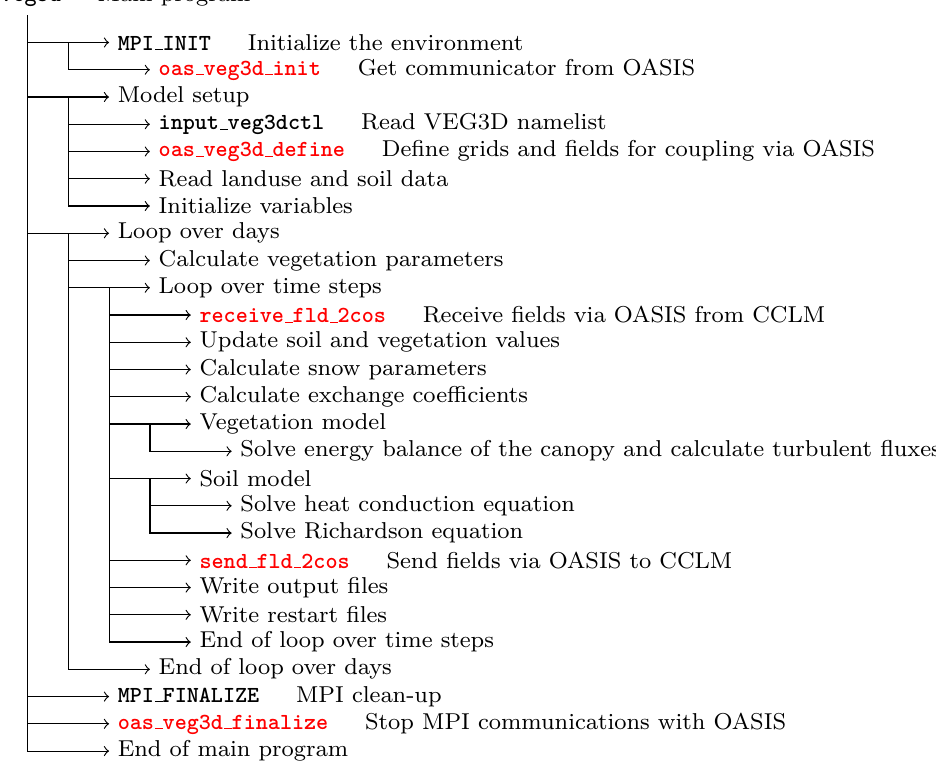
and extra cost (122.2 and 105.6 %) respectively (see line 3.3 in Table 8). They use 128 cores for each component in SMT mode with alternating processes distribution (line